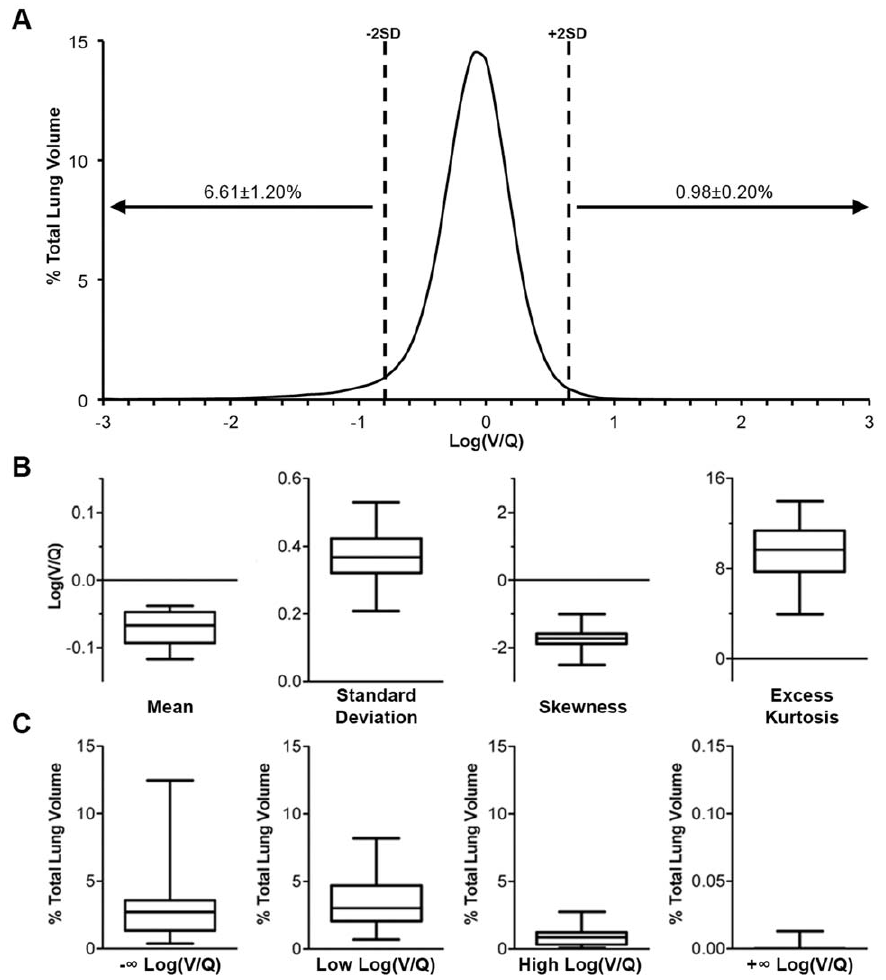
Figure 4. Distribution and measures of log(V/Q) data. A Average volume-standardized distribution of log(V/Q) values measured in percentage of total lung volume. Dashed lines indicate average 6 2 standard deviations from the average mean. Values over arrows represent average 6 SEM percentage of lung volume beyond 6 2 standard deviations, including log(V/Q) 6 ‘ values. B Descriptive analysis of log(V/Q) distribution central tendency and variation within the lung, calculated without 6 ‘ values. C Percentage of total lung volume with log(V/Q) mismatching. Mismatching is defined as values greater or less than 2 average standard deviations from the average mean. 2‘ and + ‘ refer to voxels where V=0 and Q=0, respectively. Box plots describe the data for all 12w.o. animals in terms of the median, interquartile range, and minimum/maximum